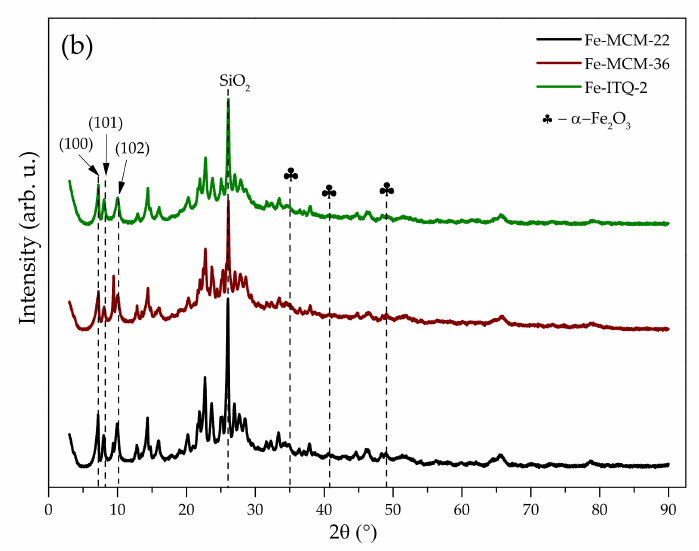
Figure 1. XRD patterns of the investigated materials: ( a ) MCM-22 (P) and its pristine derivatives in 2 θ range of 2–40 ◦ ; ( b ) iron-modified layered zeolites in 2 θ range of 3–90 ◦